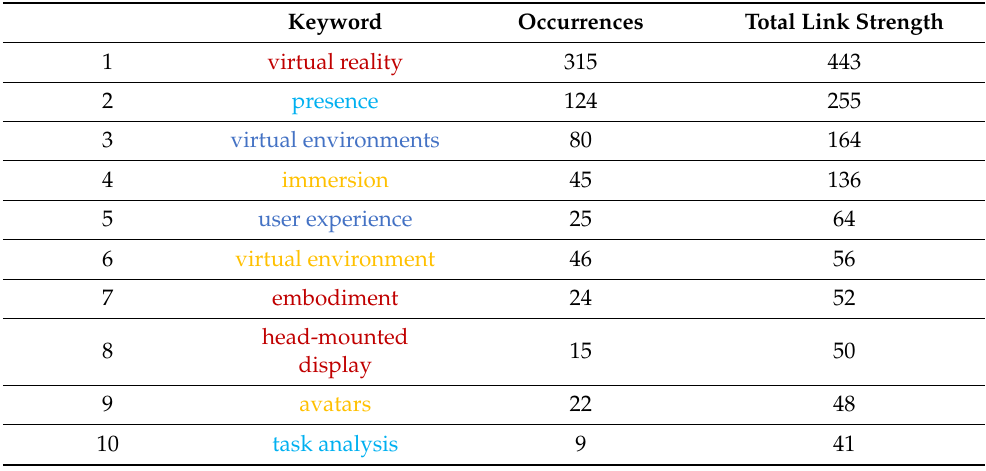
Figure 13. Co-occurrence analysis map of author keywords. Table 11. Top 10 most co-occurring keywords colored by clusters and their relationships (Source: Authors).